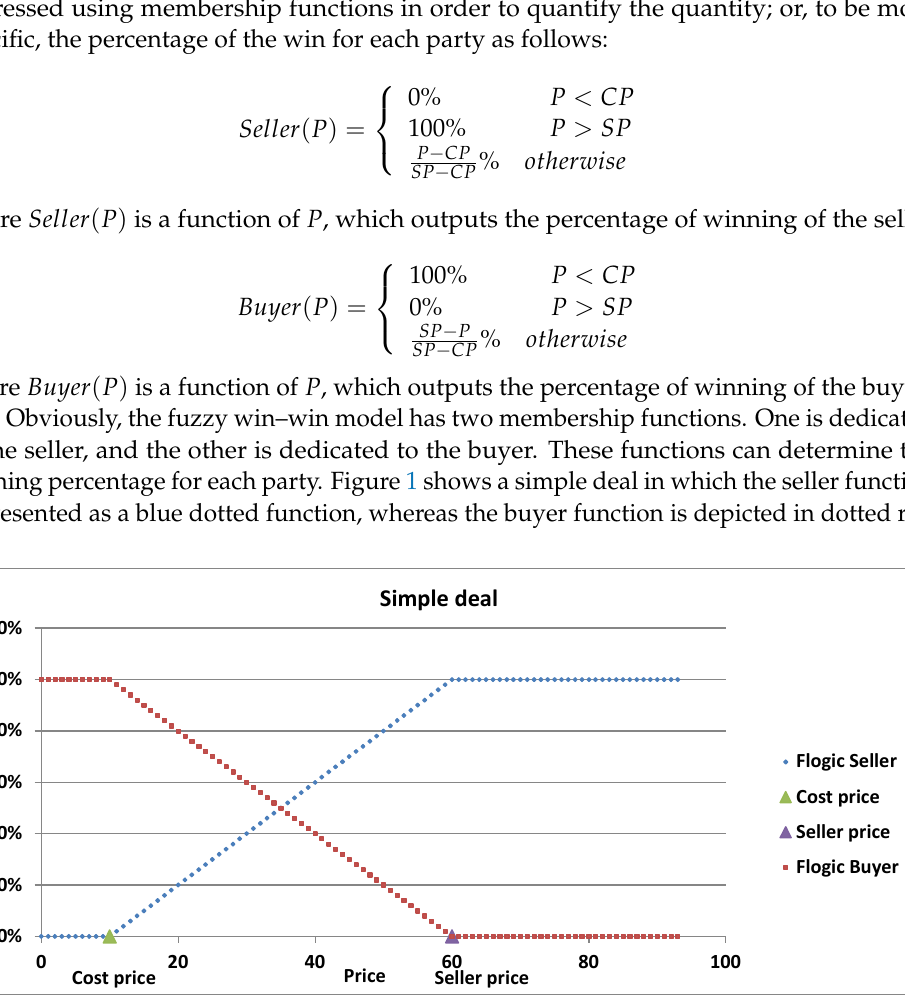
Figure 1. Illustration of the membership function using a simple deal example. In this deal, the cost price of the product is 10 and the seller price is 60 regardless of the